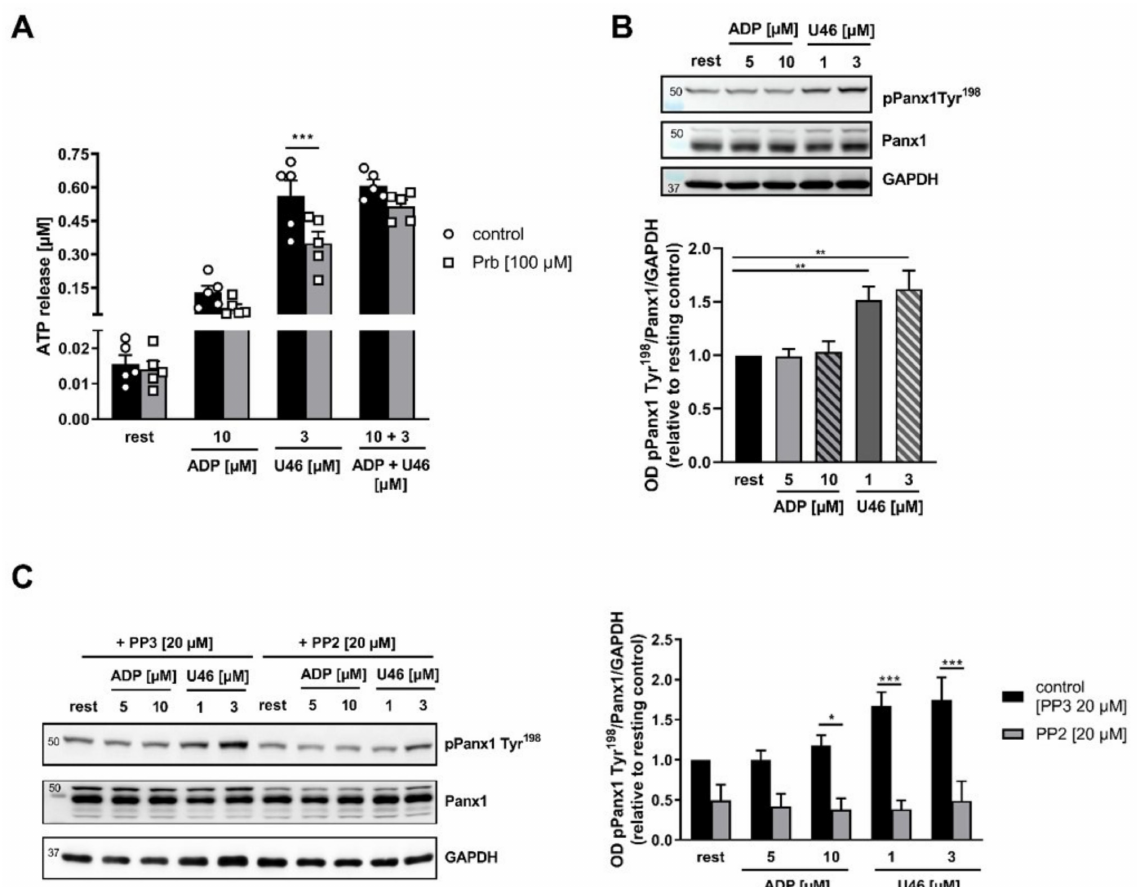
Figure 2. U46619 but not ADP activates PANX1 via phosphorylation of Tyr 198 in human platelets: ( A ) Isolated platelets were pre-incubated with the PANX1 inhibitor Prb and ATP release was mea- sured following stimulation with ADP and U46619 ( n = 5). Western Blot analysis was performed using isolated platelets that were activated with indicated concentrations of ADP and U46619. ( B ) Quan- tification of phosphorylation at PANX1 at Tyr 198 ( n = 7). ( C ) Phosphorylation of PANX1 at Tyr 198 was analyzed after pre-incubation of platelets with the SFK inhibiting compound PP2 or PP3 as a negative control ( n = 4). Statistical analysis was performed using a two-way ANOVA ( B ) compared to resting; ( A , C ) followed by a Sidak’s multiple comparisons post-hoc test. Bar graphs indicate mean values ± SEM, * p < 0.05: ** p < 0.01 and *** p < 0.001. Rest = Resting, ADP = Adenosine diphosphate, U46619 (U46) = Thromboxane analogue, Prb = Probenecid, SFK = Src family